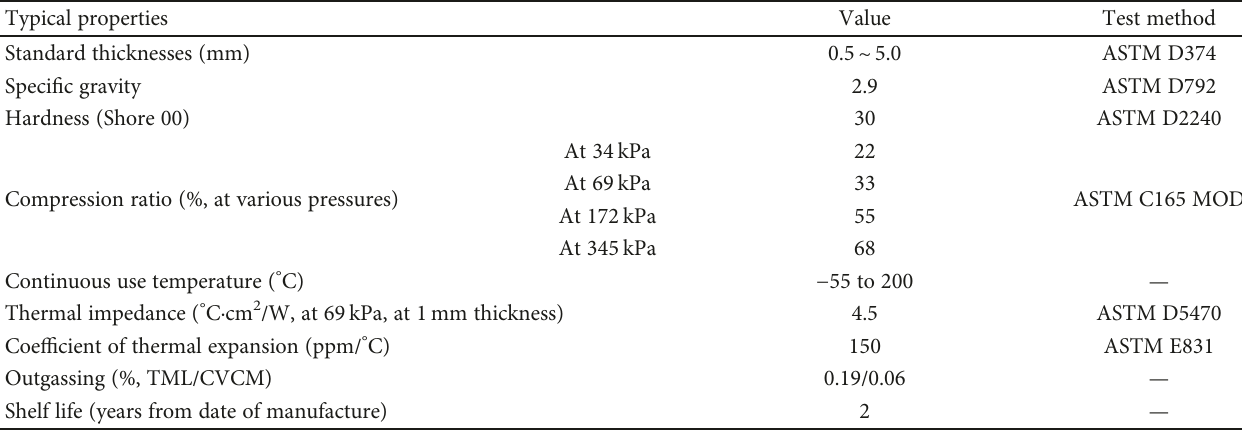
Table 1: Properties of THERM-A-GAP G579 thermal gap pad [17].